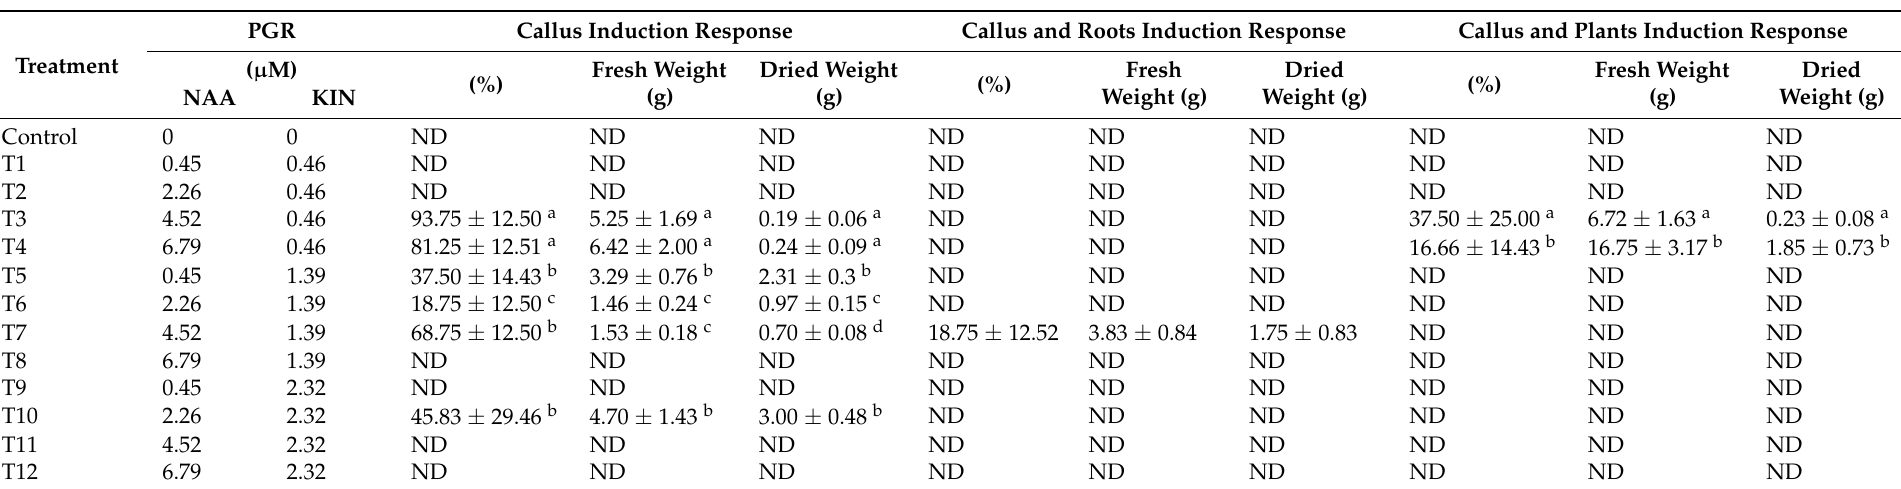
Table 1. Effect of plant growth regulators on the morphogenetic response of A. pichichensis nodal segment explants at 20 days of culture. PGR Callus Induction Response Callus and Roots Induction Response Callus and Plants Induction Treatment